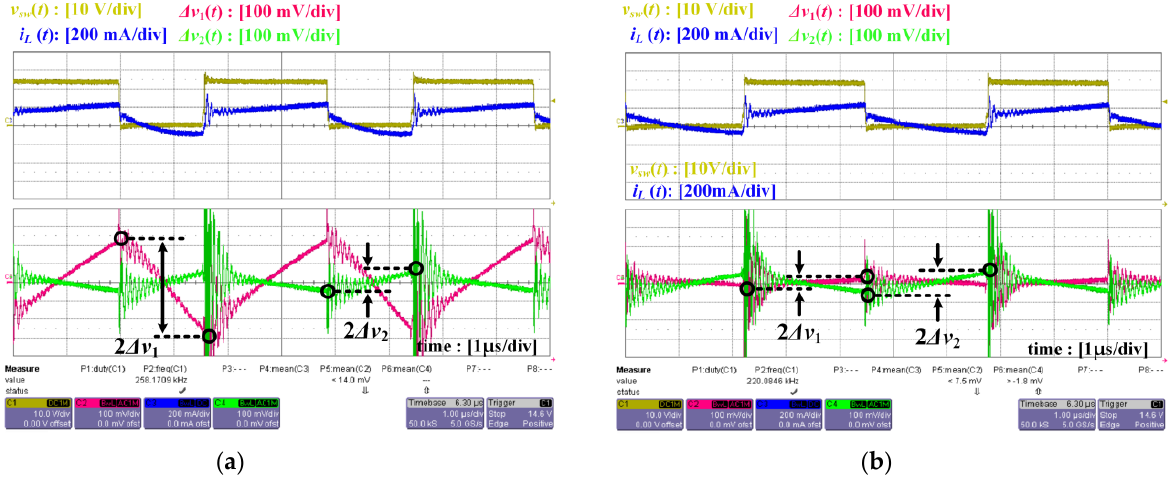
Figure 10. Experimental waveform of fly-buck converter: ( a ) C 1 = 390 nF and P 1 = P 2 = 1 W; ( b ) C 1 = 10 μ F and P 1 = P 2 = 1 W.